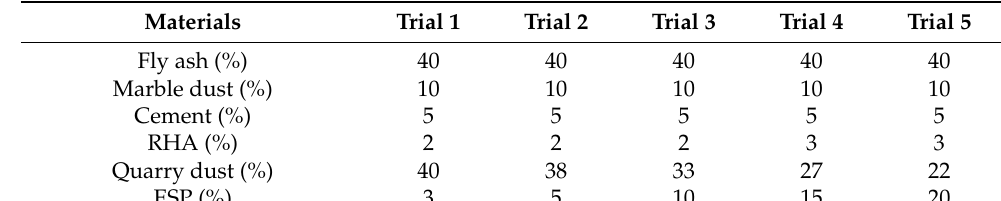
Table 2. Materials composition of various trails.